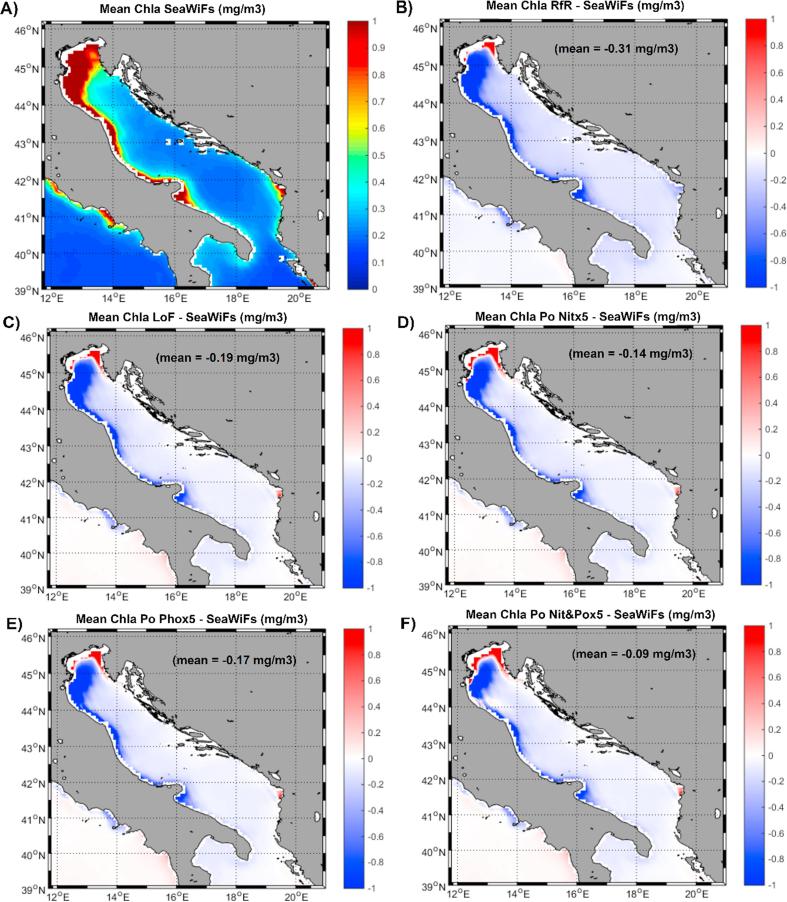
(A) Climatological (2001–2007) surface chlorophyll from SeaWiFs (mg/m3). (B) Anomalies (model – satellite) of surface chlorophyll for the RfR run (mg/m3). (C) Anomalies (model – satellite) of surface chlorophyll for the LoF run (mg/m3). (D) Anomalies (model – satellite) of surface chlorophyll for the LoF run increasing nitrate concentration in the Po River five times (mg/m3). (E) Anomalies (model – satellite) of surface chlorophyll for the LoF run increasing phosphate concentration in the Po River five times (mg/m3). (F) Anomalies (model – satellite) of surface chlorophyll for the LoF run increasing nitrate and phosphate concentrations in the Po River five times (mg/m3).